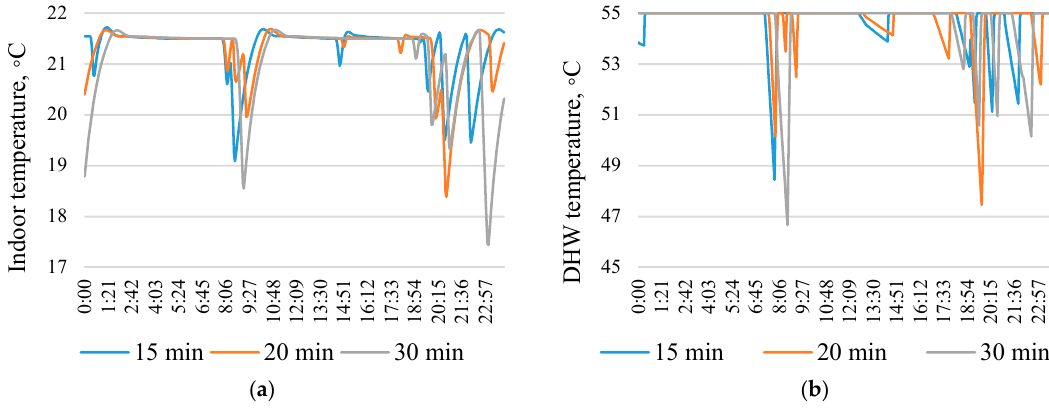
Figure 14. Effect of heating mode duration on ( a ) indoor temperature and ( b ) DHW outlet Figure 14. E ff ect of heating mode duration on ( a ) indoor temperature and ( b ) DHW outlet temperature temperature for an old single-family house occupied by six people. for an old single-family house occupied by six